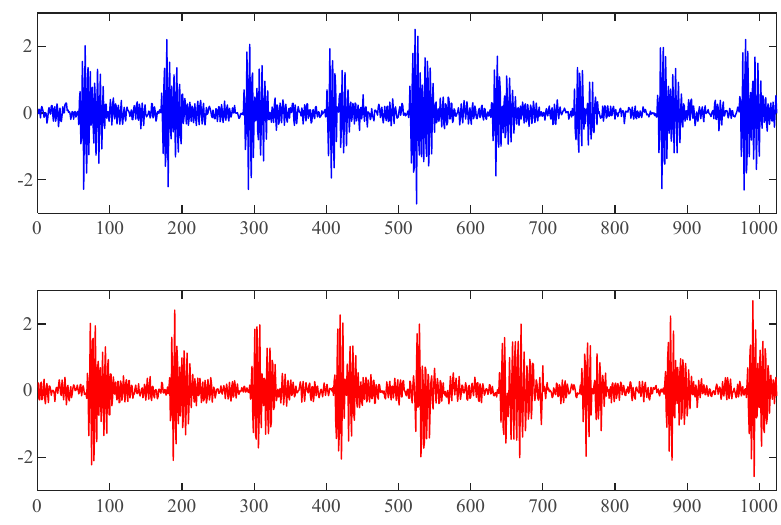
Figure 9. Vibration curves of real data (blue) and generated data (red).